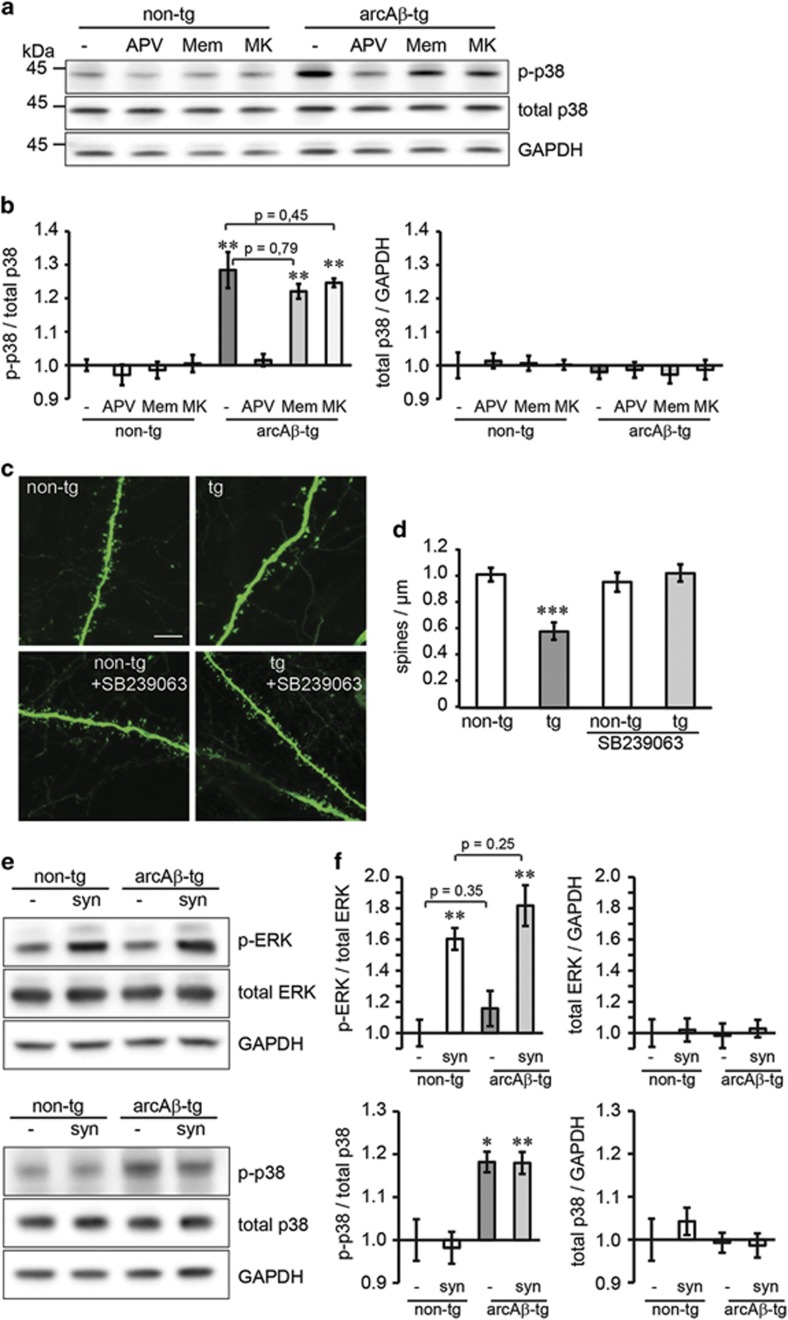
p38 MAPK is activated in arcAβ-transgenic cultures and mediates spine loss. (a) Representative western blot showing phosphorylated (active) and total p38 MAPK in lysates non-transgenic or arcAβ-transgenic slices after treatment with different NMDAR antagonists. (b) Quantification shows increased levels of phosphorylated p38 in arcAβ-transgenic cultures. The increased amounts of phospho-p38 were reduced to control levels by APV (100 μM) but not by memantine (1 μM) or MK-801 (30 μM) treatment. The non-transgenic untreated control was set to 1. n=6. (c) Confocal images of dendrites from CA1 neurons in the stratum radiatum of non-transgenic and arcAβ-transgenic hippocampal slice cultures treated with p38 MAP kinase inhibitor SB239063 (20 μM). Scale bar: 5 μM. (d) SB239063 treatment reverses the dendritic spine loss in arcAβ-transgenic cultures. n=14-16. (e) Representative western blot showing activated ERK (p-ERK) and activated p38 (p-p38) in non-transgenic or arcAβ-transgenic slices after synaptic activation with bicuculline and 4-aminopyridine. (f) Quantification shows increased p-ERK levels after synaptic activation, independent of transgenic background. Synaptic activation does not affect p-p38 levels. n=5. All values are shown as mean±S.E.M. (*P<0.05, **P<0.01, ***P<0.001; two-tailed unpaired Student's t-test; significances indicate differences to the respective non-tg control; for p-ERK/total ERK significances indicate differences to the respective non-activated culture). non-tg, non-transgenic; tg, arcAβ transgenic; Mem, memantine; MK, MK-801; p-ERK, phospho-ERK; p-p38, phospho-p38 MAPK; syn, synaptic activation